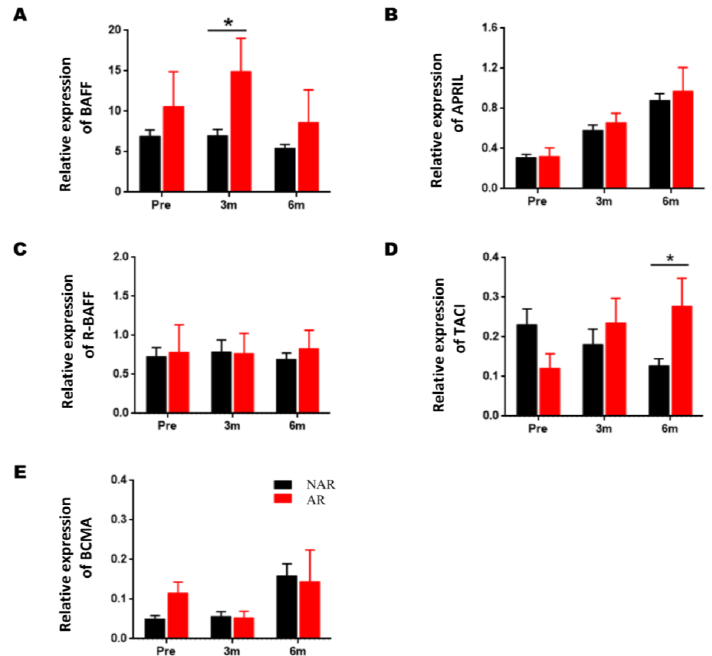
Figure 3. Association of the gene expression of BAFF, APRIL, and their receptors (R-BAFF, TACI, and BCMA) with acute rejection. Comparison of BAFF ( A ), APRIL ( B ), R-BAFF ( C ), TACI ( D ), and BCMA ( E ) gene expression levels in peripheral blood samples among KTRs without (NAR, n = 35) and with acute rejection (AR, n = 5), obtained pre- and at three- and six-months post-transplantation. The HPRT gene was used as an endogenous control to normalize BAFF and APRIL gene expression, and the CD19 gene to normalize R-BAFF, TACI, and BCMA gene expression. Expression data are represented as the mean ± SEM. Statistical analyses were carried out using the Mann – Whitney U test. Values of p < 0.05 were considered significant. * p < 0.05.